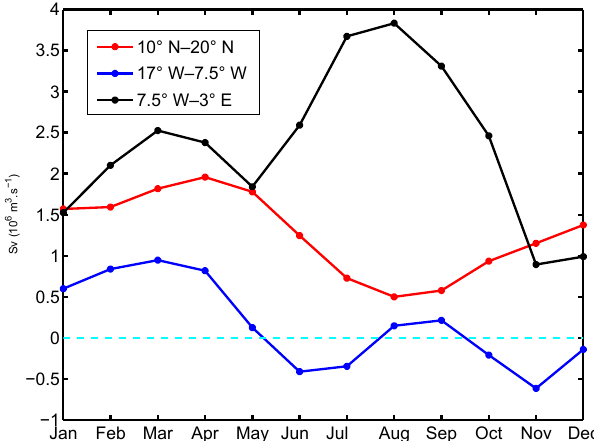
Figure 13. Monthly mean climatology of across-shore Ekman transport (Sv) integrated along the 100m isobath for three sectors: in the Gulf of Guinea between longitudes 3.5 ◦ E and 7.5 ◦ W (black; GG), further west between 7.5 and 17 ◦ W (blue; WAC), and be- tween 10 and 20 ◦ N (red; WA). The position of these sectors, which are of comparable length, is indicated in Figs. 1a and